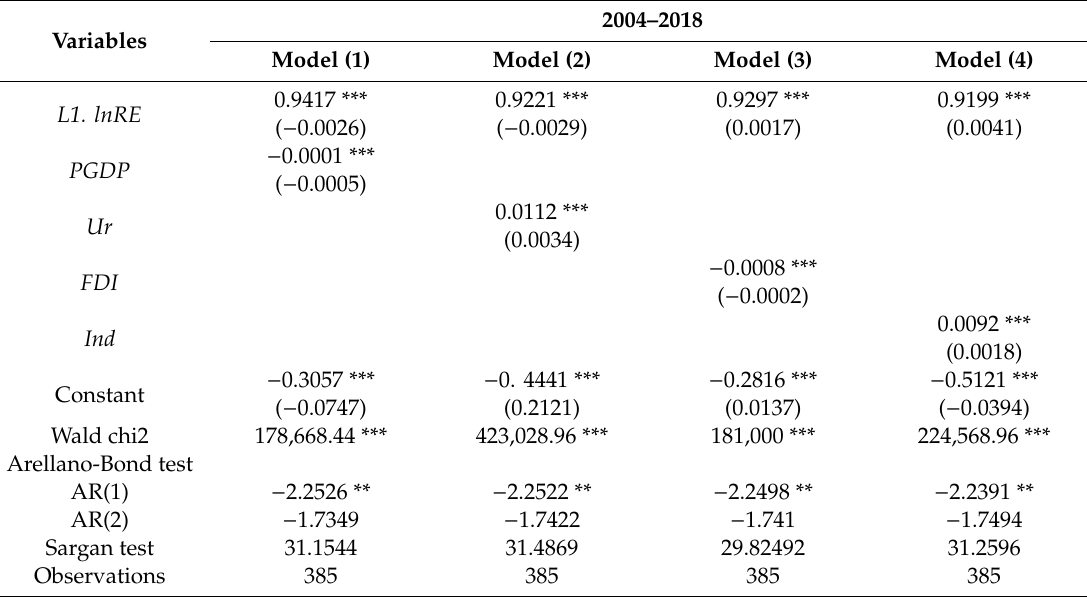
Table 3. β -convergence